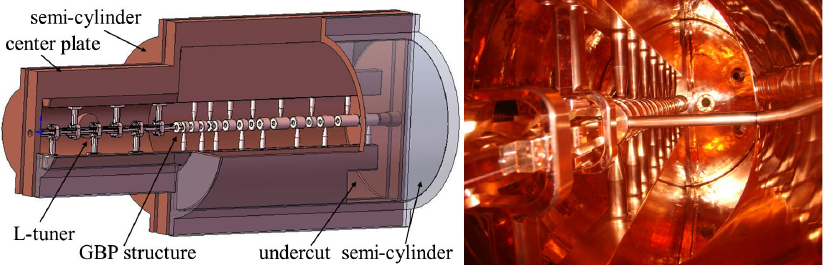
FIG. 2. Before and after assembly images of the HSC linac. The HSC linac was assembled by using a sandwich method (a center plate and two semicylinders).